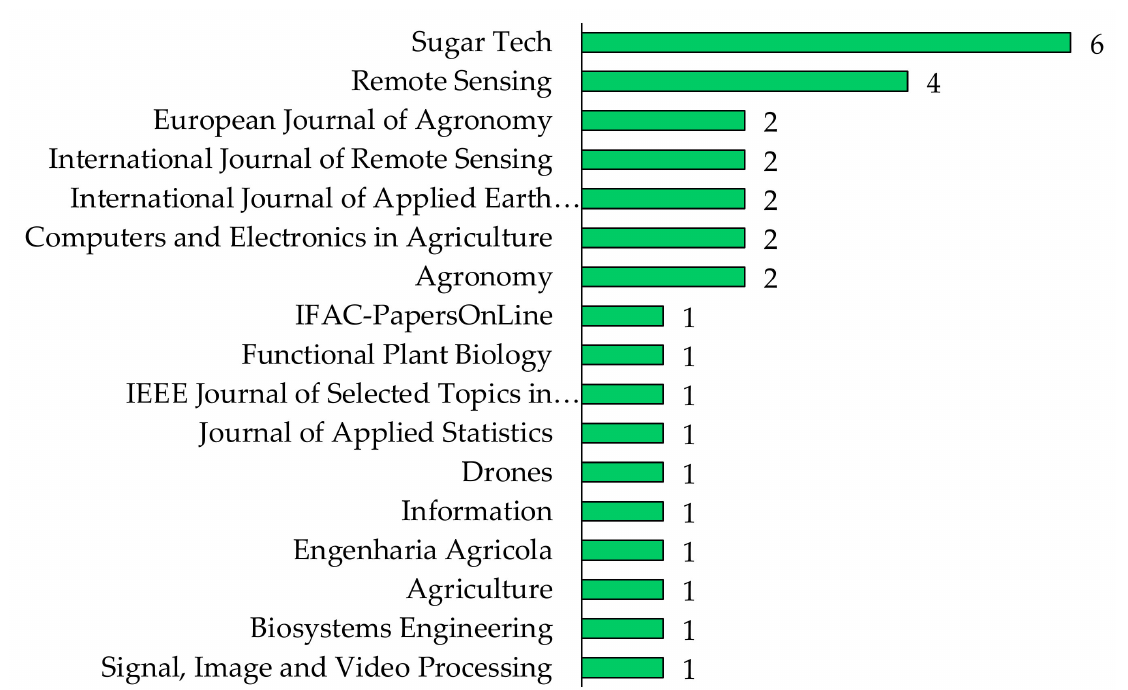
Figure 2. Number of relevant publications in UAVs for sugarcane by peer-reviewed